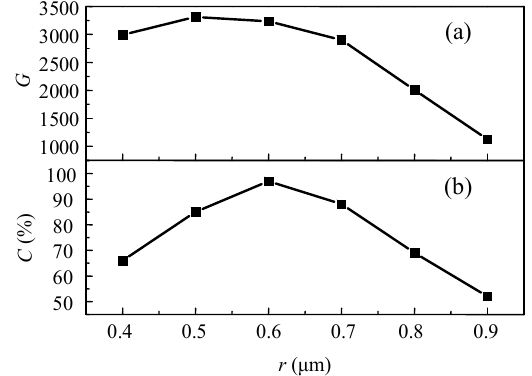
Fig. 4 Energy density ratio G and absorption efficiency C as a function of the radius r of the gold disk: (a) energy density ratio G as a function of the radius r of the gold disk and (b) absorption efficiency C as a function of the radius r of the gold